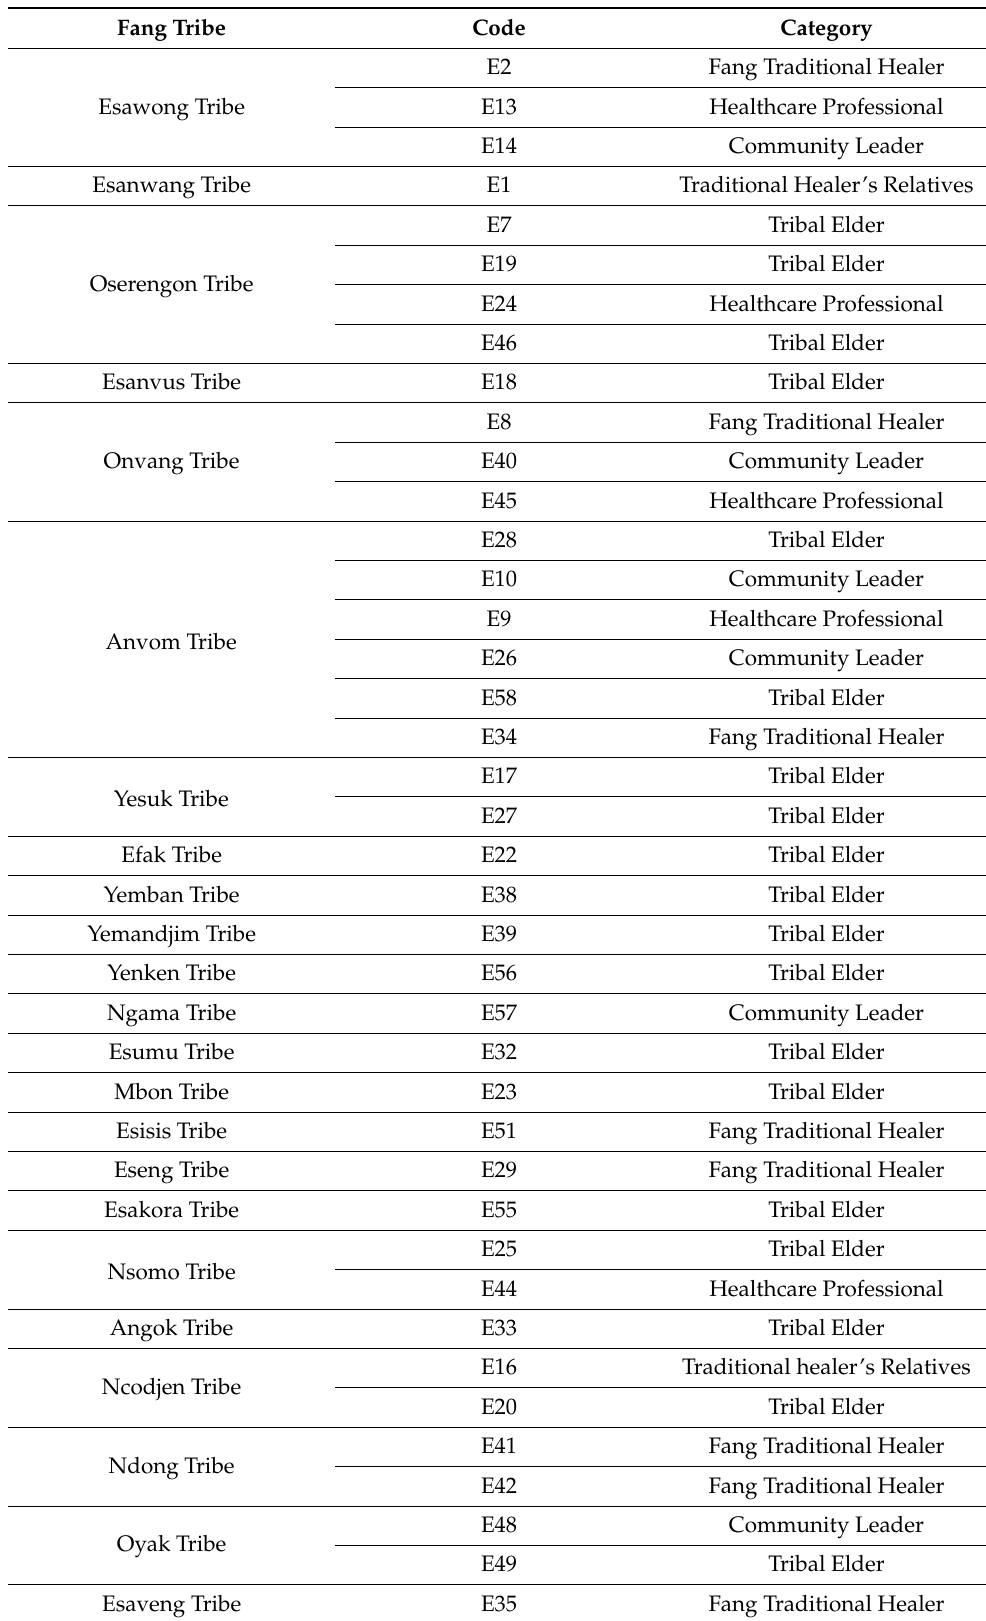
Table 2. Fang tribes and category of participants (n = 45). Esawong